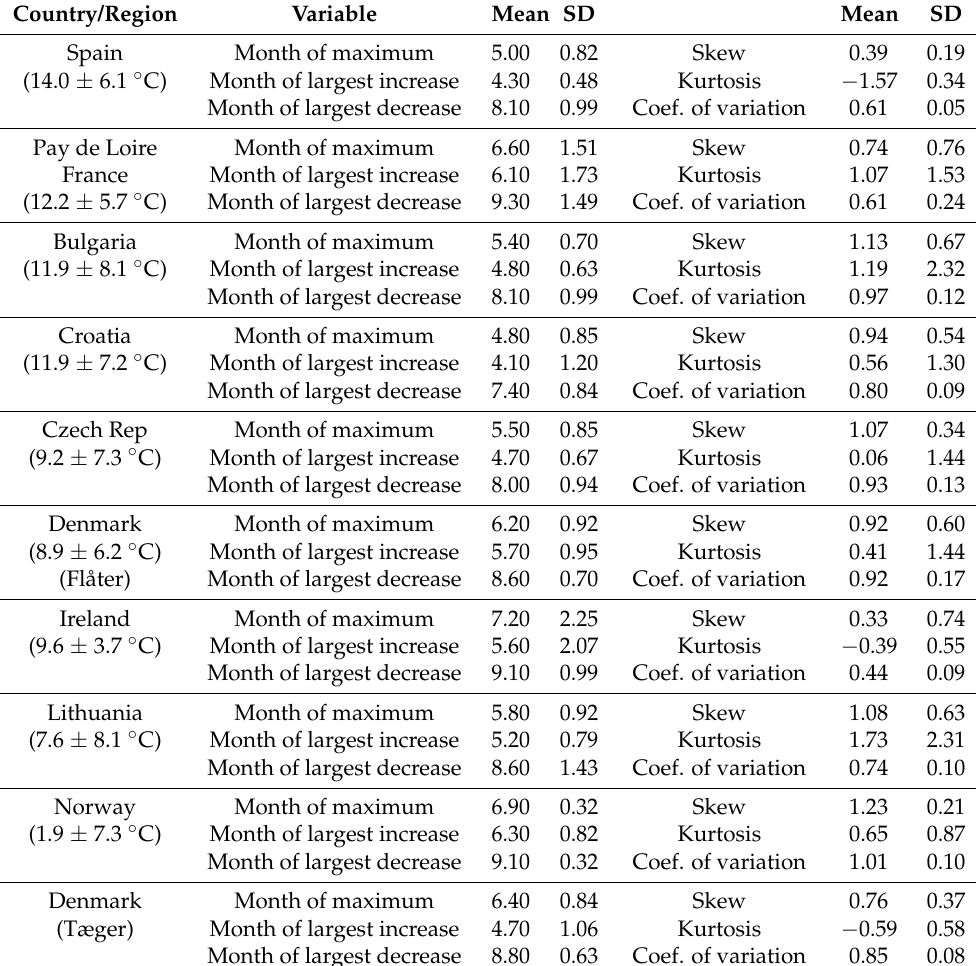
Table 2. Descriptive statistic for monthly tick-search-term frequencies in each of the 10 years (mean ± sd) covering the period 2007 to 2016 in nine European countries. The month of the largest in- crease and decrease in search frequencies was assessed by linear regression over the current and past two months and month where after the maximum and minimum slope was identified or each